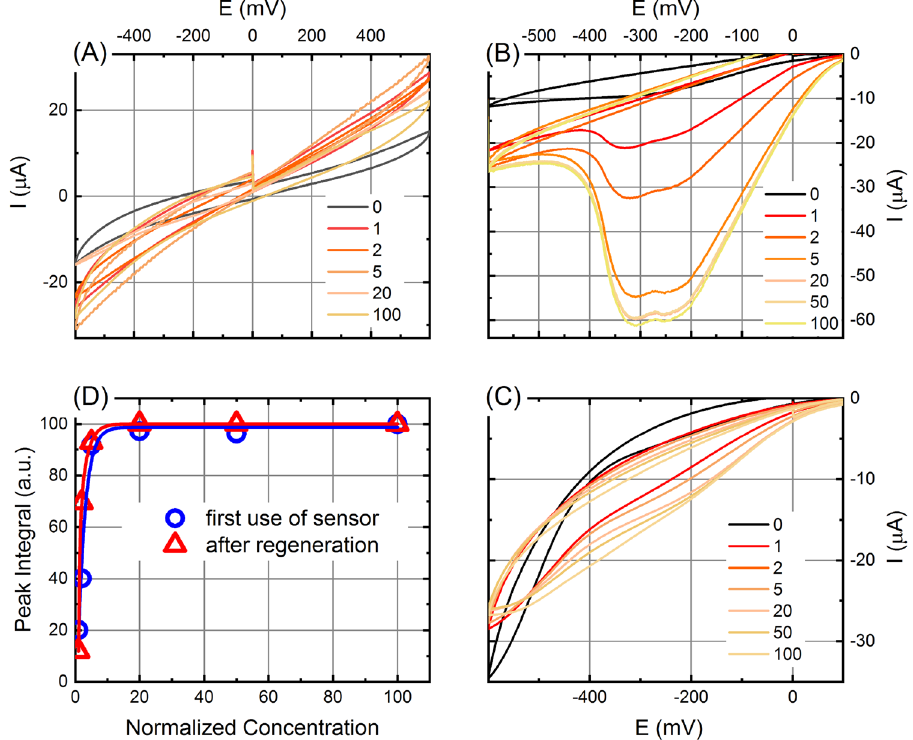
Figure 5. Set of CV curves measured in the presence of As(III) on wild type flagellar nanotubes ( A ) as well as on FliC-ArsR9 As-binding flagellar nanotubes before ( B ) and after ( C ) storage and regeneration. The numbers of the color code in the legend show the concentrations in units (U) of WHO threshold limit. Subfigure ( D ) shows the areas for FliC-ArsR9 filament cathodic peaks after first use and after regeneration calculated by averaging four measurements calculated using the method described in the text as a function of the As(III) concentration in U. The solid lines show exponential fits to the measured data points. The reproducibility